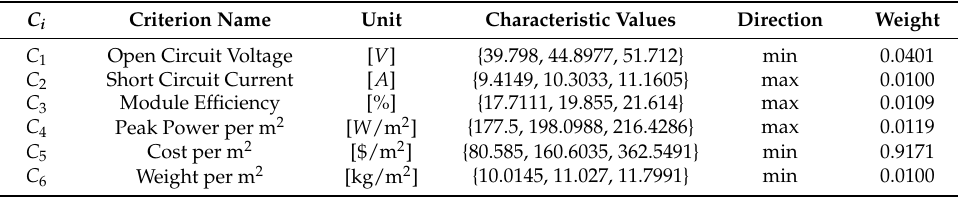
Table 3. Criteria selected for evaluation alternatives.